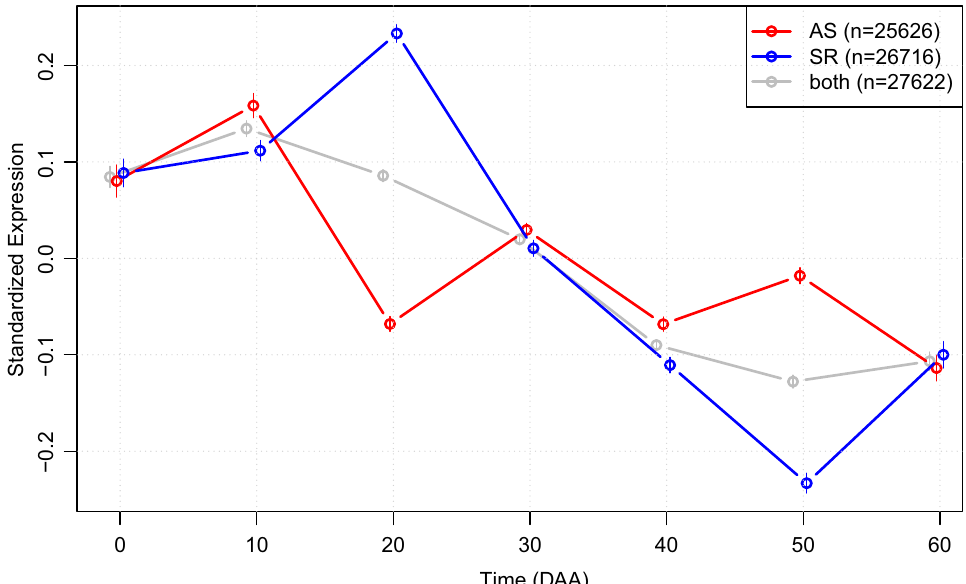
Figure 5. Plot of average Standardized Expression Profiles (SEPs) in groups formed by accessions “AS” (in red), “SR” (in blue) and the SEPs including all genes from both accessions (in grey). Thin vertical lines over the circles 4 marking each mean are the 99.99% ( α = 1 × 10 − ) confidence intervals (CI’s) for the means. Plot obtained with function “ SEPs.plot() ”.